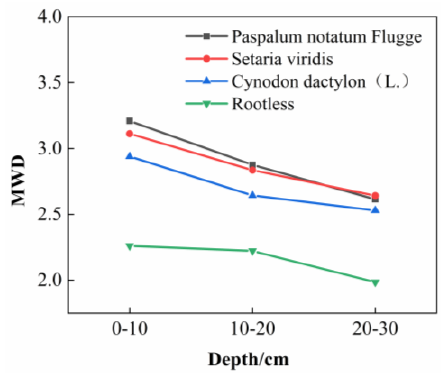
Figure 11. The effect of depth on MWD.